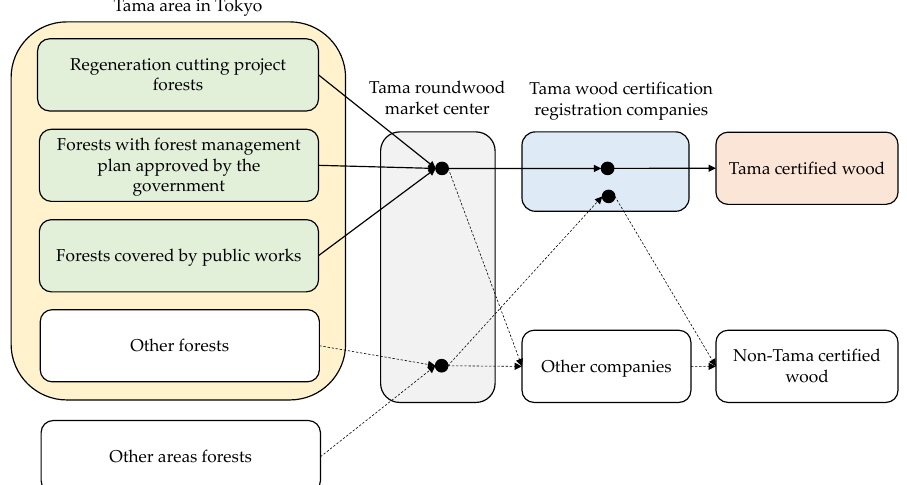
Figure 1. Structure of the Tama certification scheme. The raw wood along the path of the solid line is treated as Tama-certified wood. Raw wood in the path indicated by the dashed line is not treated as Tama-certified wood.